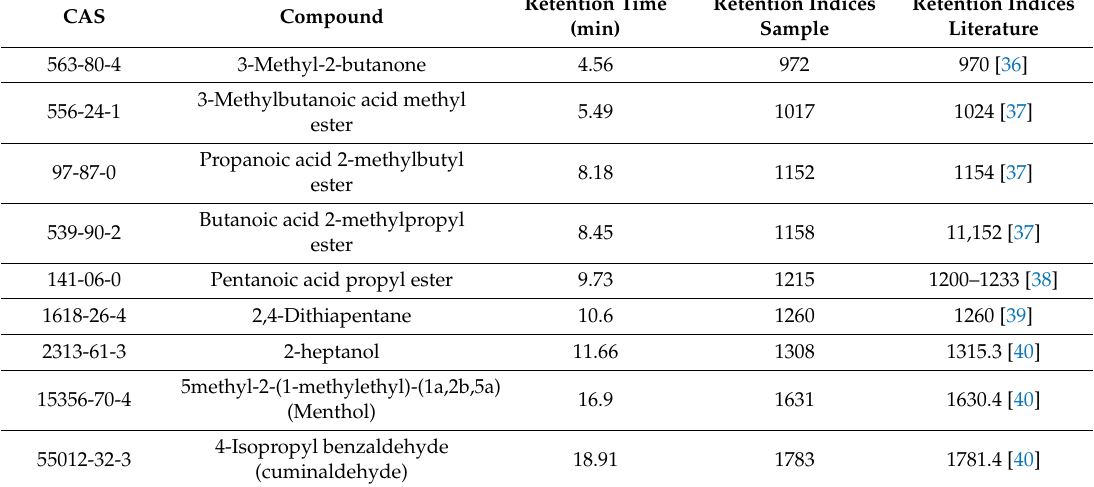
Table 5. Details of 12 compounds identified from the headspace above stool samples from healthy individuals that have not been previously reported in the literature [31].